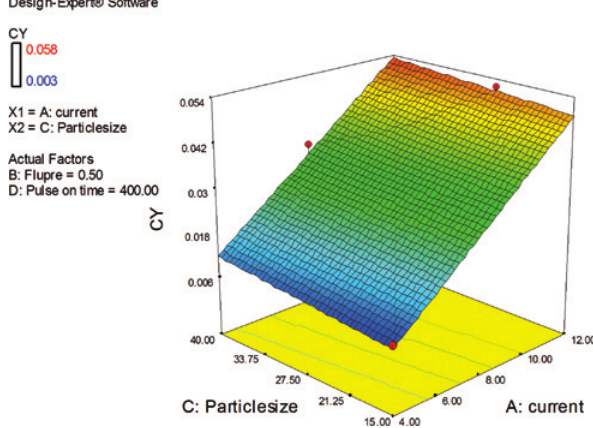
Figure 11 Interactive effect of current and particle size on CY.